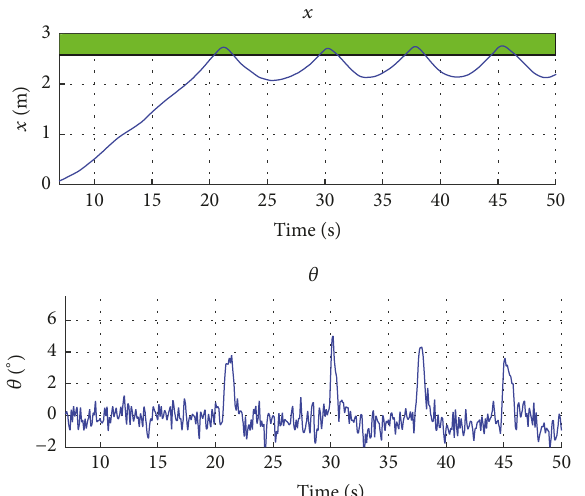
Figure 15: PID controller: hovering in partial ground effect. Simu- lation with sensor noise.